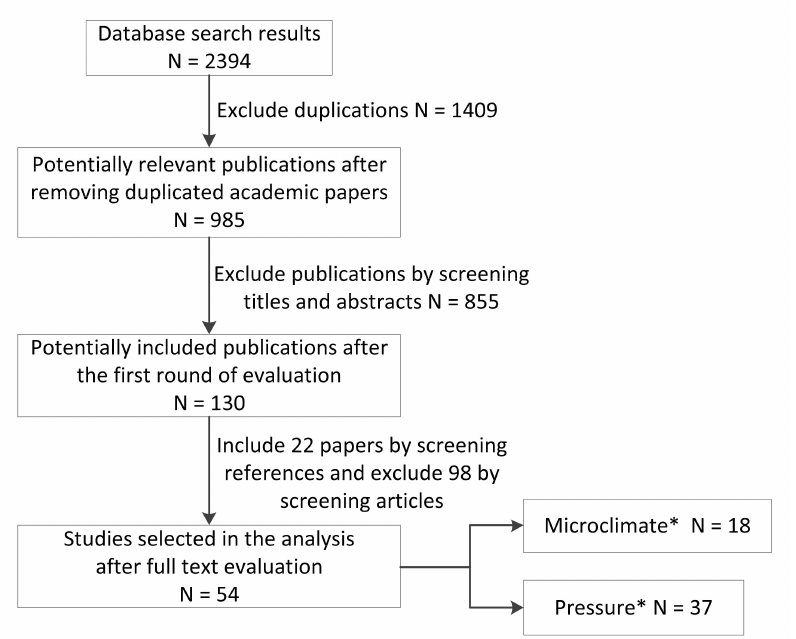
Figure 2. Flow chart of literature selection through the review phases. * Reference [15] includes both microclimate and pressure measurements; therefore, it was included in both categories. As a result, although the total number of included publications is N = 54, the sum of the two categories is greater ( N = 37 + 18 =